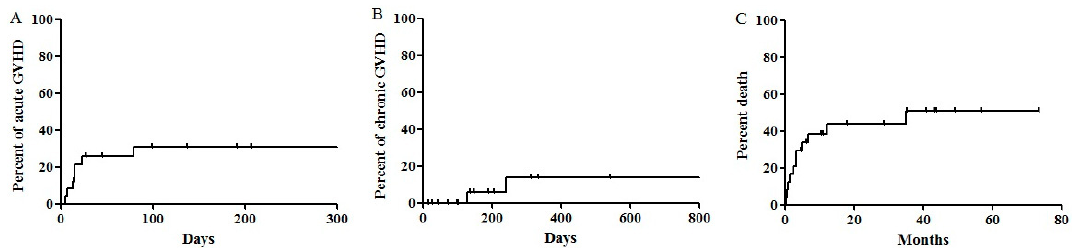
Figure 2. Allogeneic stem cell transplantation outcomes. ( A ) Acute graft-versus-host disease (GVHD) (cumulative incidence of acute GVHD for 100 days: 30.6 ± 9.7%) ( B ) Chronic GVHD (1-year cumulative incidence of chronic GVHD: 13.7 ± 9.2%) ( C ) Non-relapse mortality (one-year cumulative incidence of NRM: 38.3 ± 10.1%).